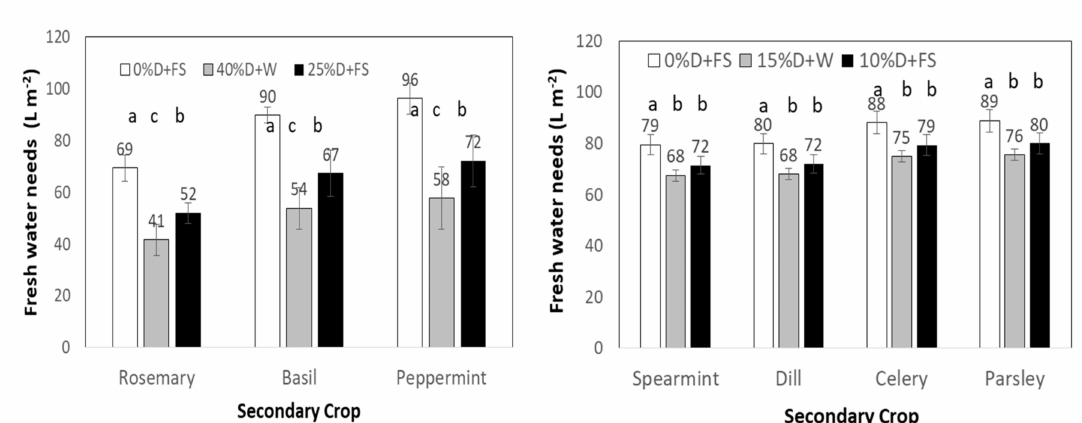
Figure 1. Total needs of fresh water (L m − 2 ) of the secondary crops during the ( a ) 1st and ( b ) 2nd Periods, respectively. The mean value is above each bar. Di ff erent letters within crops indicate statistically significant di ff erences ( p <